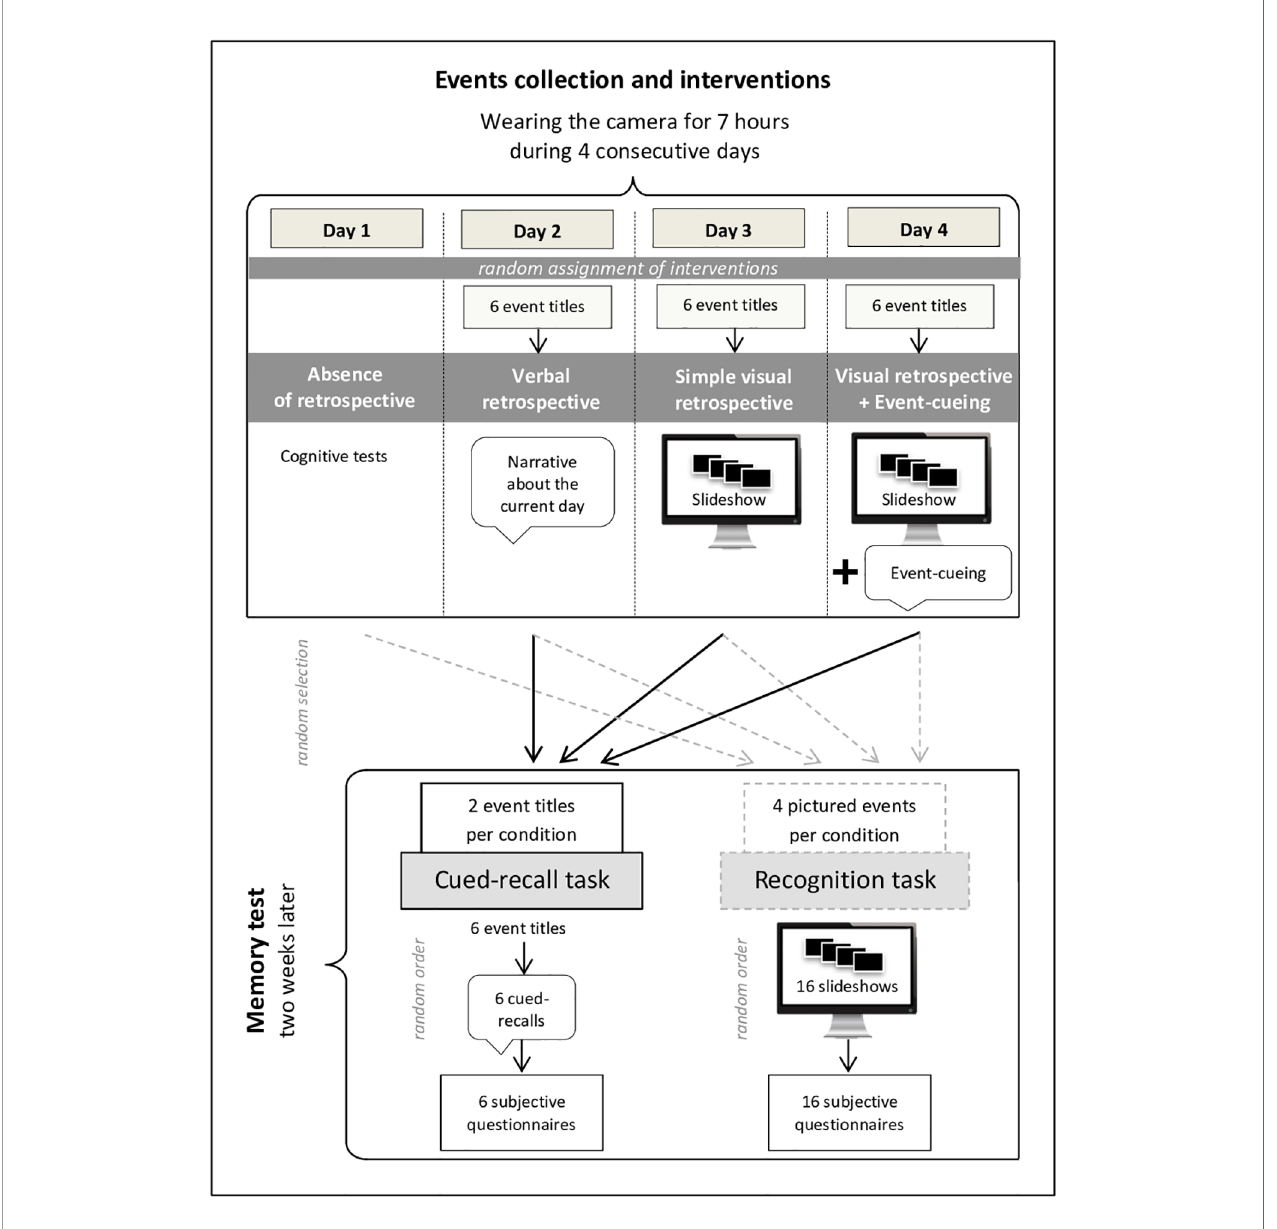
FIGURE 1 | Schematic of the experimental protocol ’ s design, including the events collection phase and the memory